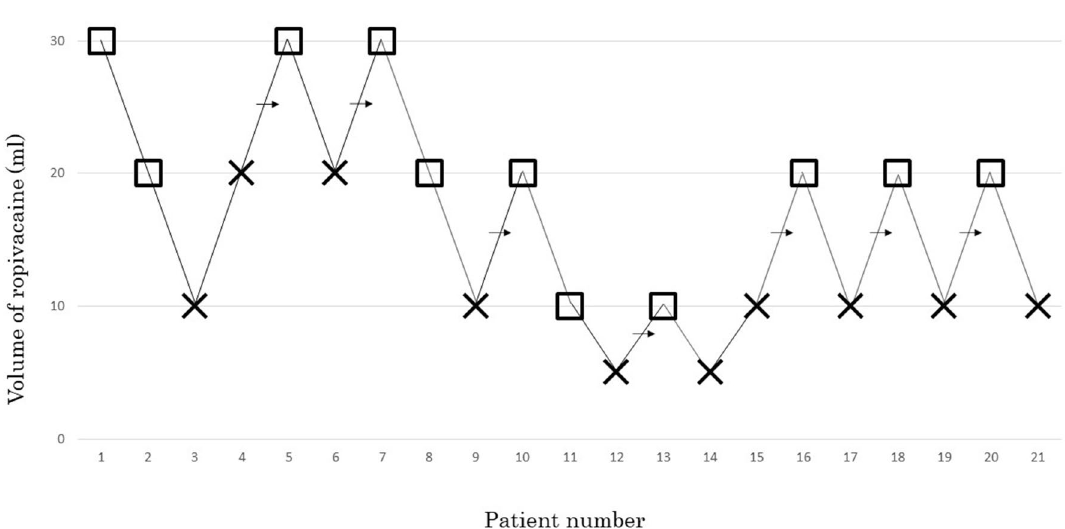
Figure 2. The up-and-down sequence of volumes of ropivacaine 0.25% required for supra-inguinal ultrasound- guided fascia iliaca compartment block to produce effective femoral nerve block and lateral cutaneous nerve block. × failed block, □ = effective block, → mid-point of “failed-effective”